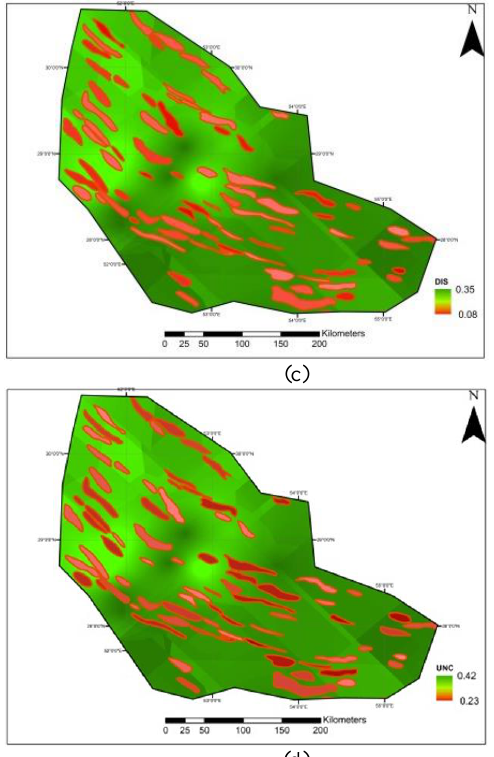
Figure 7. Integrated maps of evidence theory functions for PBE: